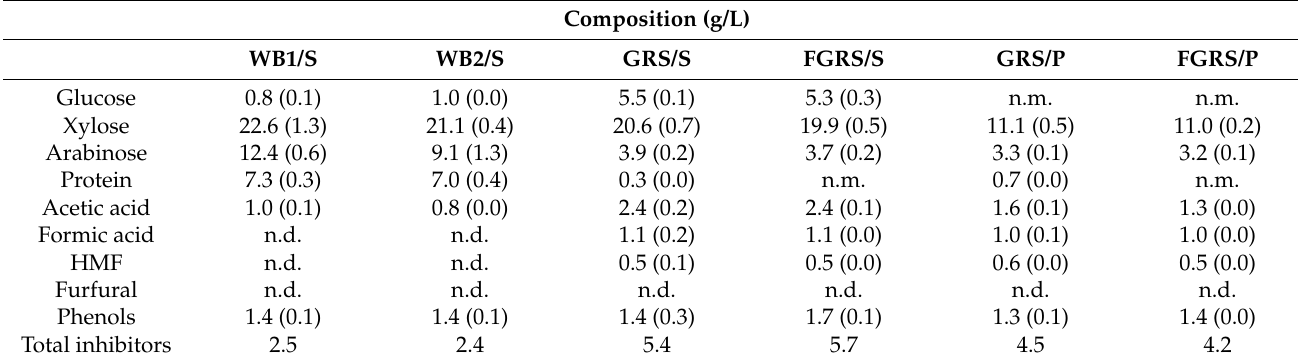
Table 4. Composition of different lignocellulosic